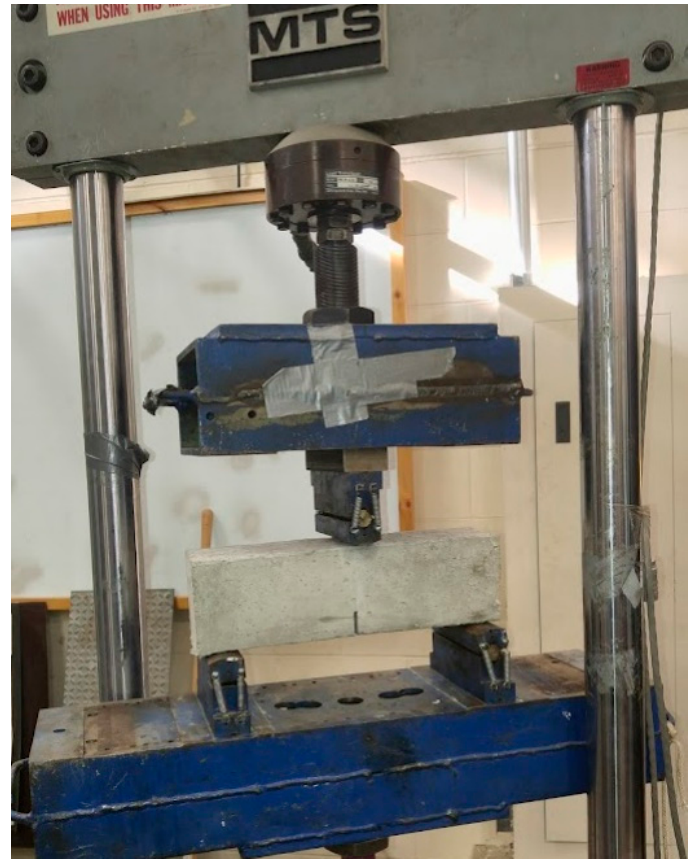
Figure 6. Three-point bending test set-up.